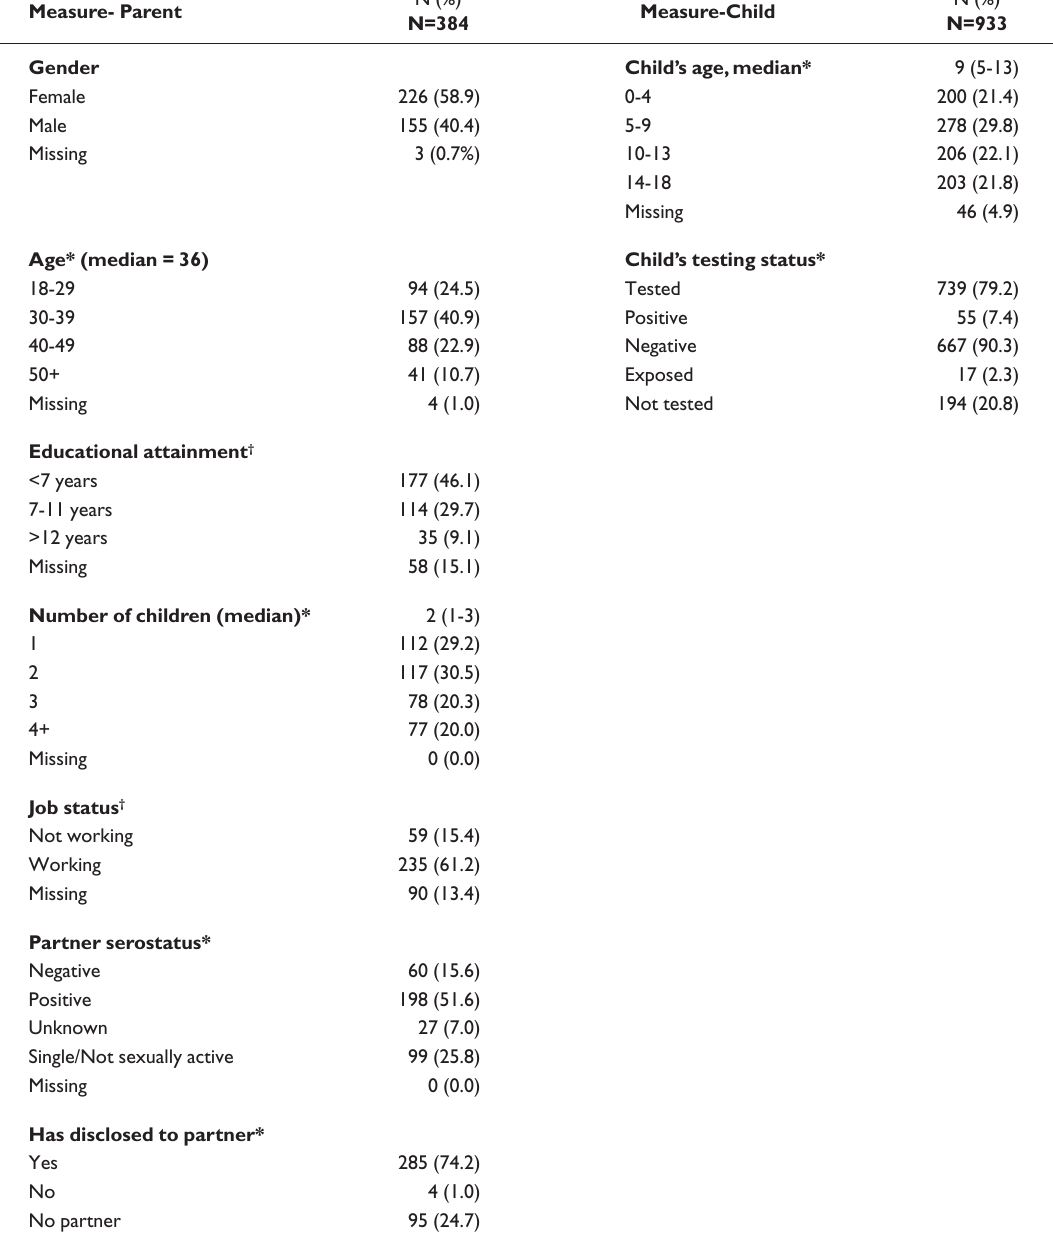
Table 1 Socio-demographic characteristics of families assessed using the Family Information Table